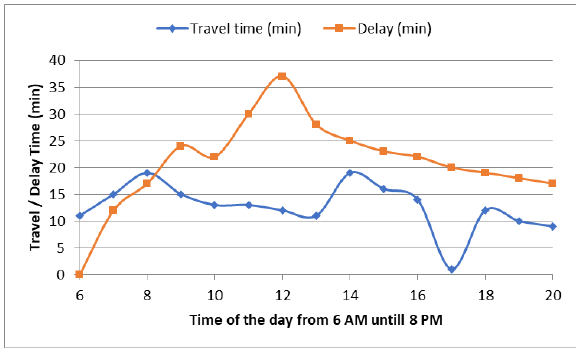
Fig. 3. Travel time and Delay of Trucks in the 6 th ring